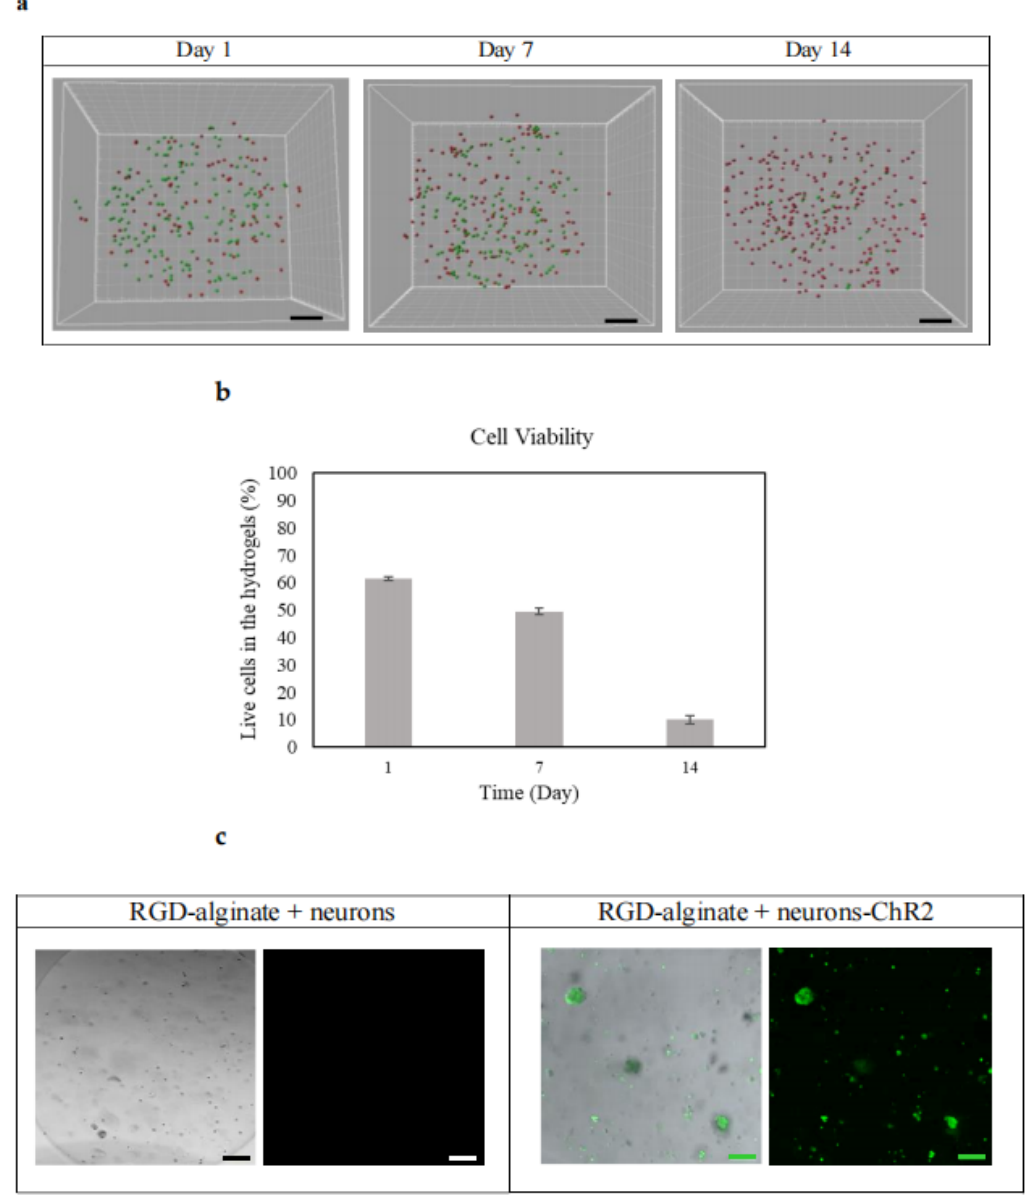
Figure 5. Cell viability and localization of optogenetically engineered neurons encapsulated in the RGD-alginate hydrogels and expression of ChR2 in the hydrogels from day 1 to day 14. ( a ) Live–dead cell staining (Calcein-AM, Sigma-Aldrich, St. Louis, MI, USA) was performed. A series of z-stack images were captured using fluorescence microscopy (Nikon T i Eclipse, Tokyo, Japan) and processed with IMARIS software (version 8, Bitplane, Belfast, UK). Live cells were stained green whilst dead cells were stained red. Scale bar: 200 µ m. ( b ) Quantitative analysis of live–dead cells ( n = 3). ( c ) After 24 h of encapsulation, the cells encapsulated with RGD-alginate hydrogels were investigated using a confocal microscope (Zeiss-LSM 780, Oberkochen, Germany) to evaluate the expression of ChR2 (labeled in green) as well as the morphology and distribution of cells within the 3D culture system. Non-transduced or unmodified cells were used as a control. Scale bar: 100 µ